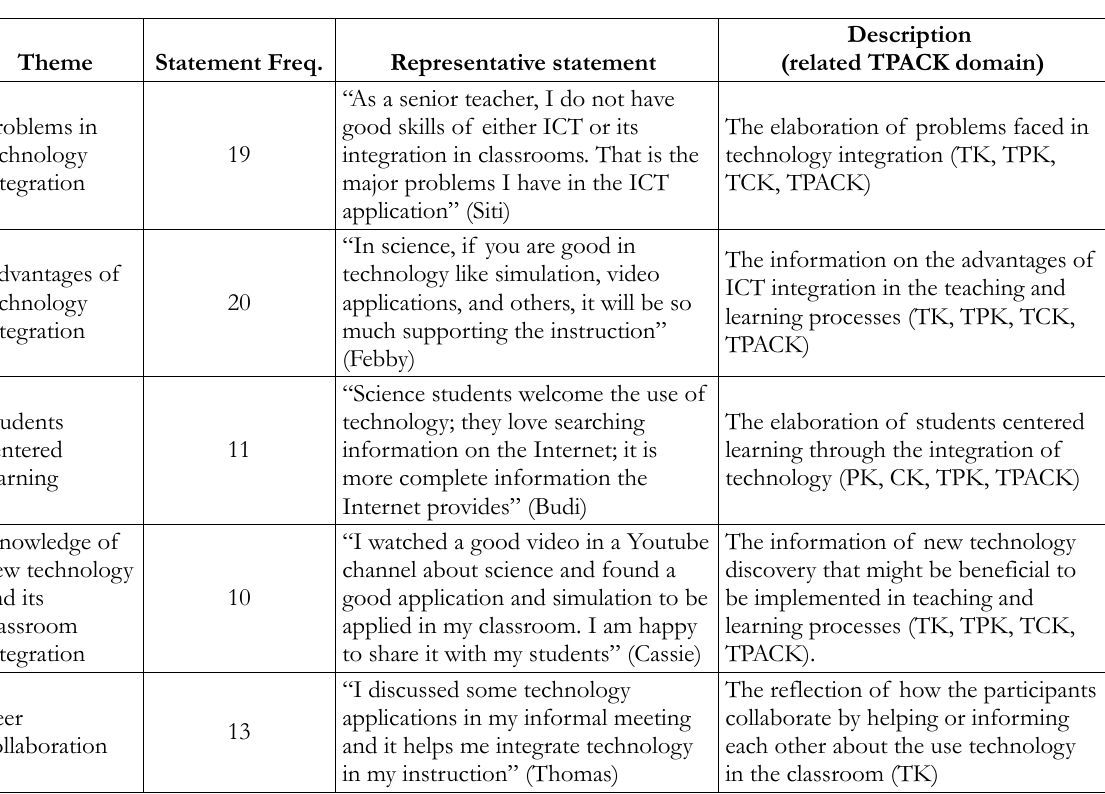
Table 7. Qualitative thematic evidence of